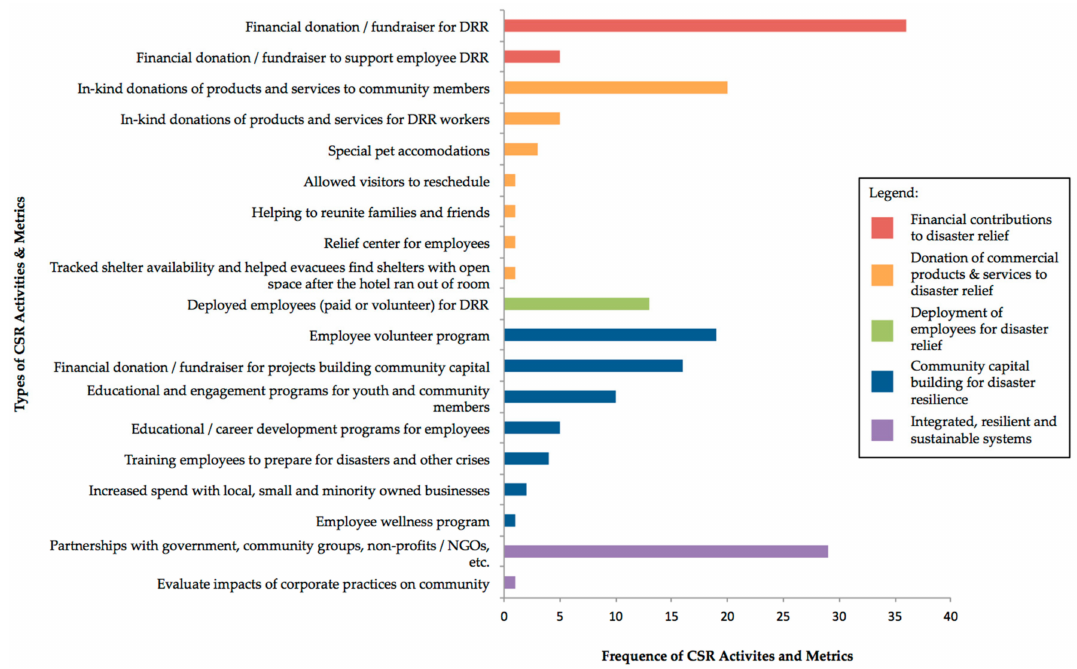
Figure 1. Frequency of socially valuable activities supporting disaster relief and